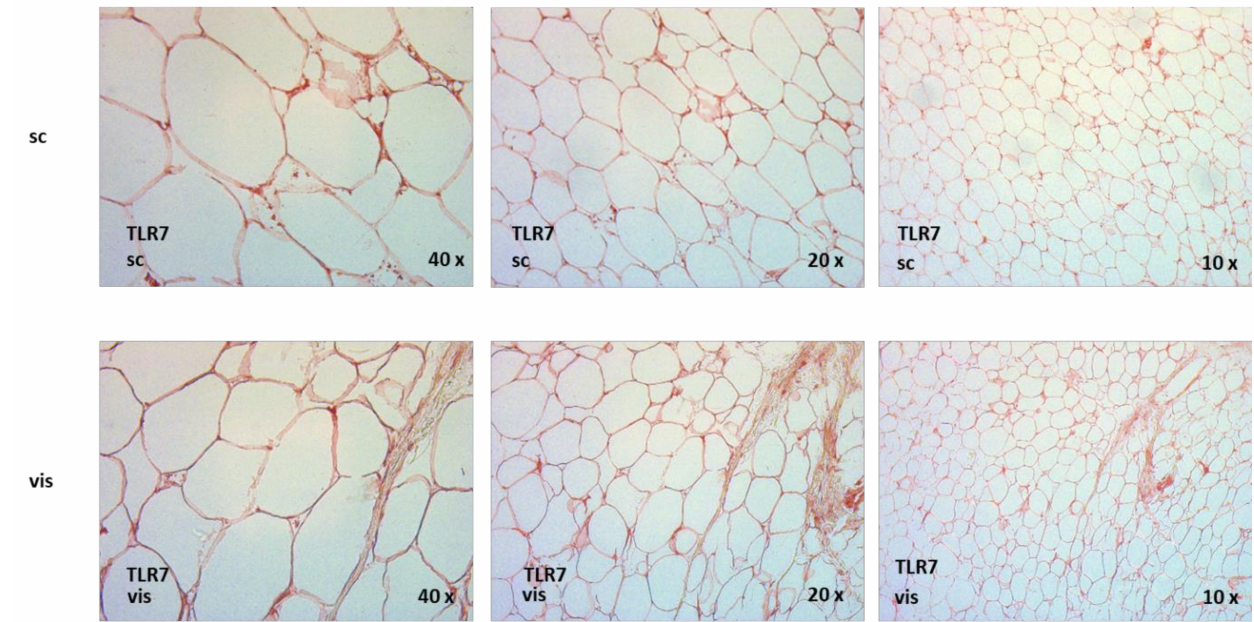
Figure A6. TLR7 protein is expressed in visceral and subcutaneous adipose tissue of obese, non- diabetic patients. TLR7 protein expression was detected and visualized via immunohistochemistry in visceral (vis) and subcutaneous (sc) adipose tissue of obese, non-diabetic patients (representative sections are shown).